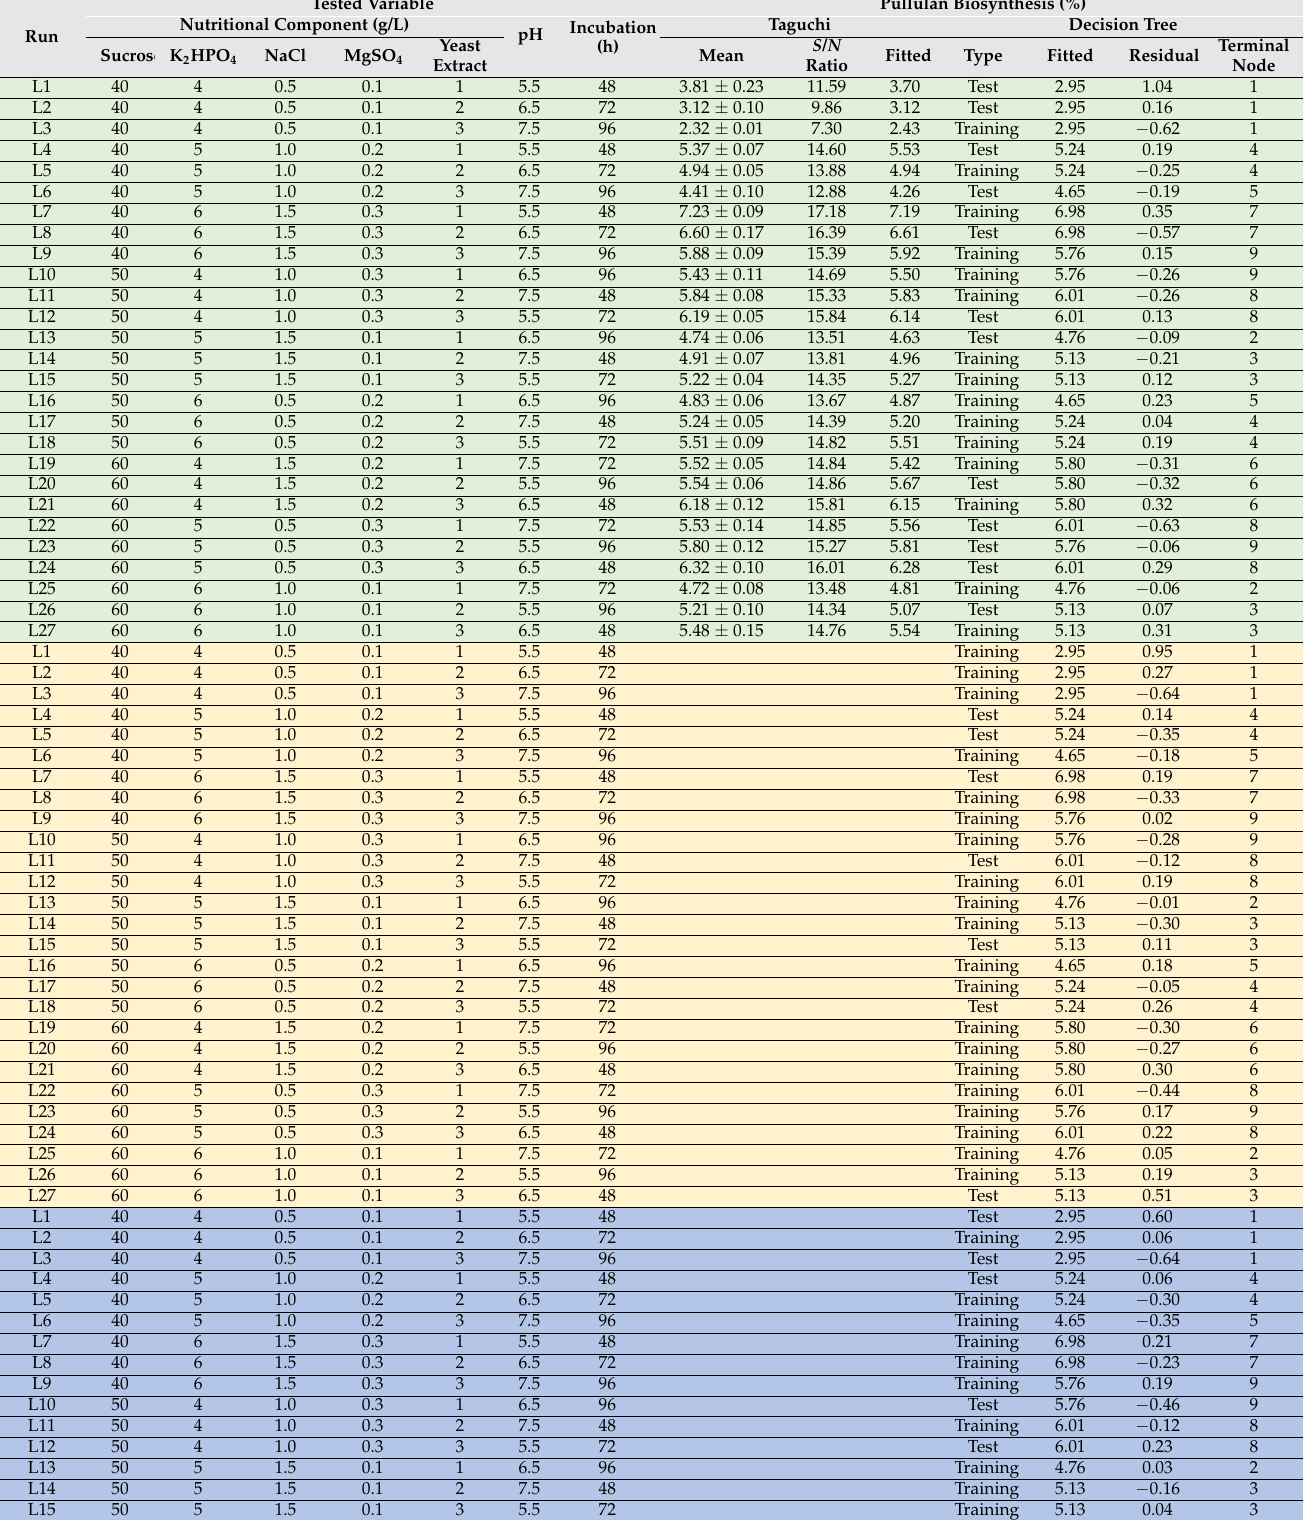
Table 1. Orthogonal array and predicted values of Taguchi’s L 27 (3 7 ) for optimization of pullulan biosynthesis by A. pullulans , as well as the predicted and residual values and terminal nodes of the decision tree learning algorithm at each data point. The experiment was repeated in three separate runs denoted by different